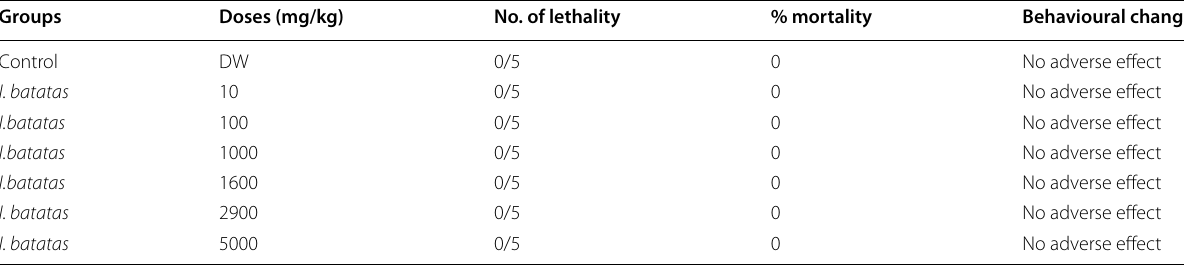
Table 1 Acute toxicological effect of Ipomoea batatas L . on Swiss mice Groups